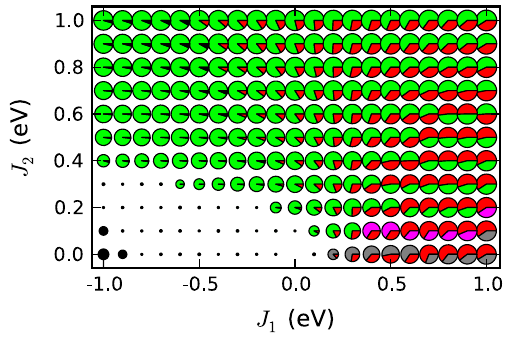
FIG. 14. The phase diagram of the three-pocket model. Here we are able to resolve the s -wave channel into constant s wave wave (green), and the nodal s wave (gray), extended s x 2 y 2 x 2 þ y 2 (purple). See the caption to Fig. 10 for more details on the pie FIG. 16. Typical RG flows and the superconducting gaps as- (cid:5) (cid:1) 1 and J (cid:5) 0 have highly charts. Parameter sets with J sociated with FS setup for the three-pocket scenario with 1 2 Þ ¼ ð 0 : 9 ; 0 : 3 Þ eV . Leading form factor is denoted in blue, ð J ;J oscillating form factors due to artifacts in the calculation; the 1 2 triplet channel would have to be considered in these cases. subleading form factor in